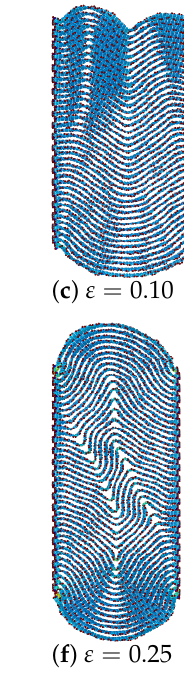
Figure 4. Deformation of armchair graphite under compression ( n =